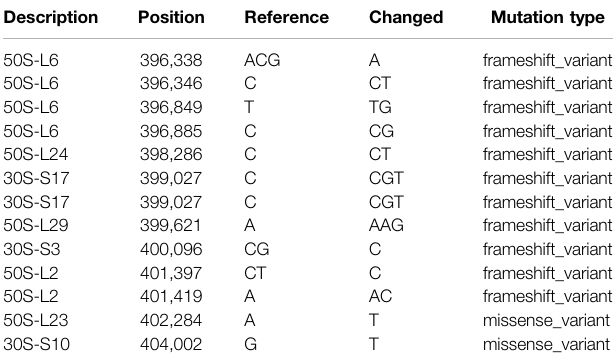
TABLE 1 | The ribosome mutation-related genes of evolved strains.